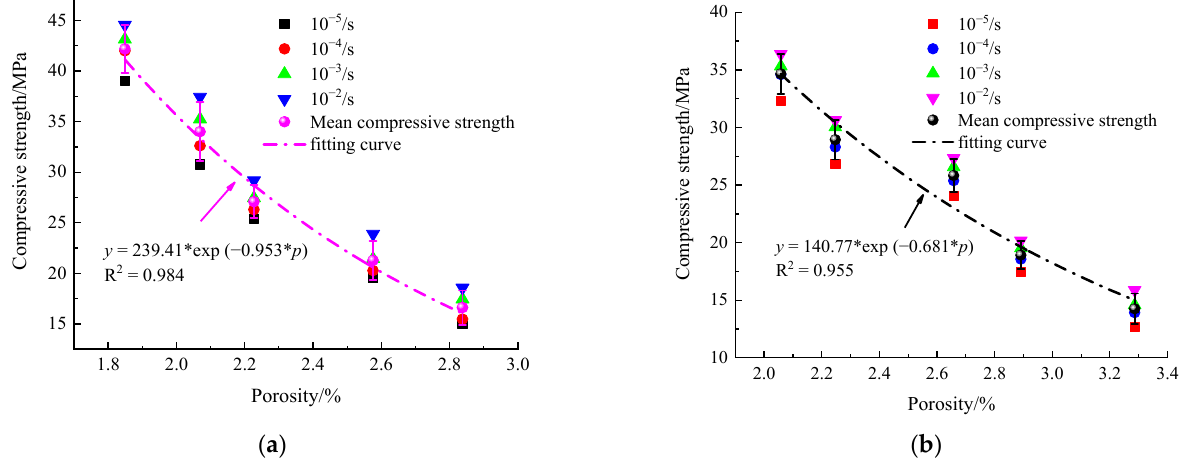
Figure 19. Relationship between compressive strength of concrete with different w/c ratio and porosity. ( a ) w/c = 0.45; ( b ) w/c = 0.55.